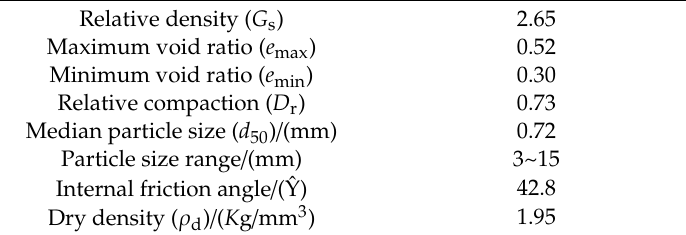
Figure 1. Particle size distribution curve of sand. Table 1. Physical properties of Qingdao sea sand.